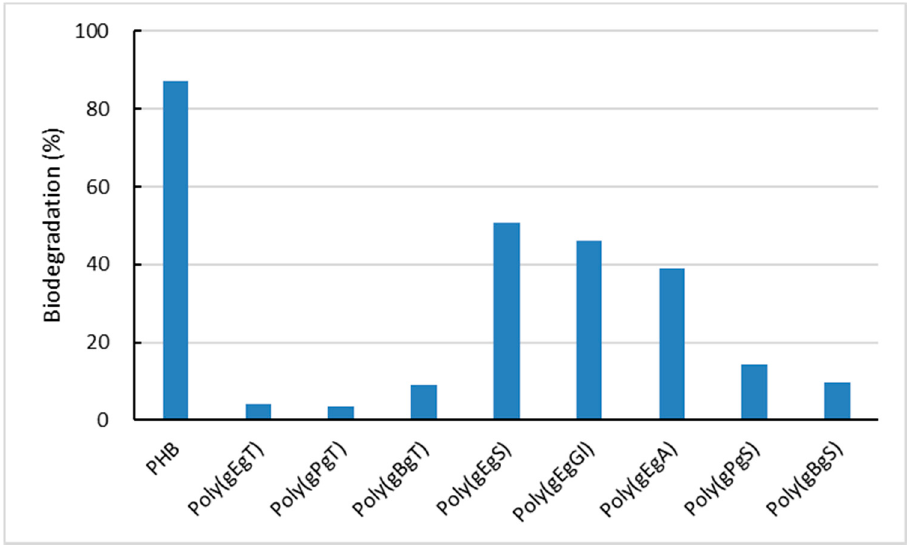
Figure 7. Biodegradation of the poly(ester amide)s in activated sludge after 32 days.